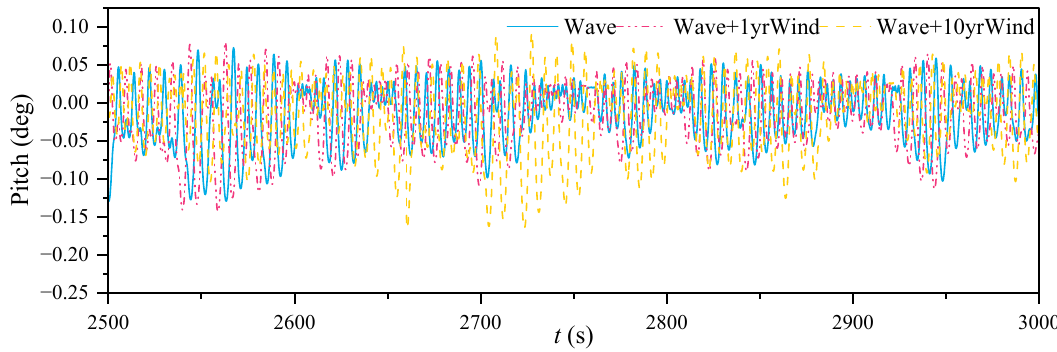
Figure 18. Pitch response under wave load and wind load.